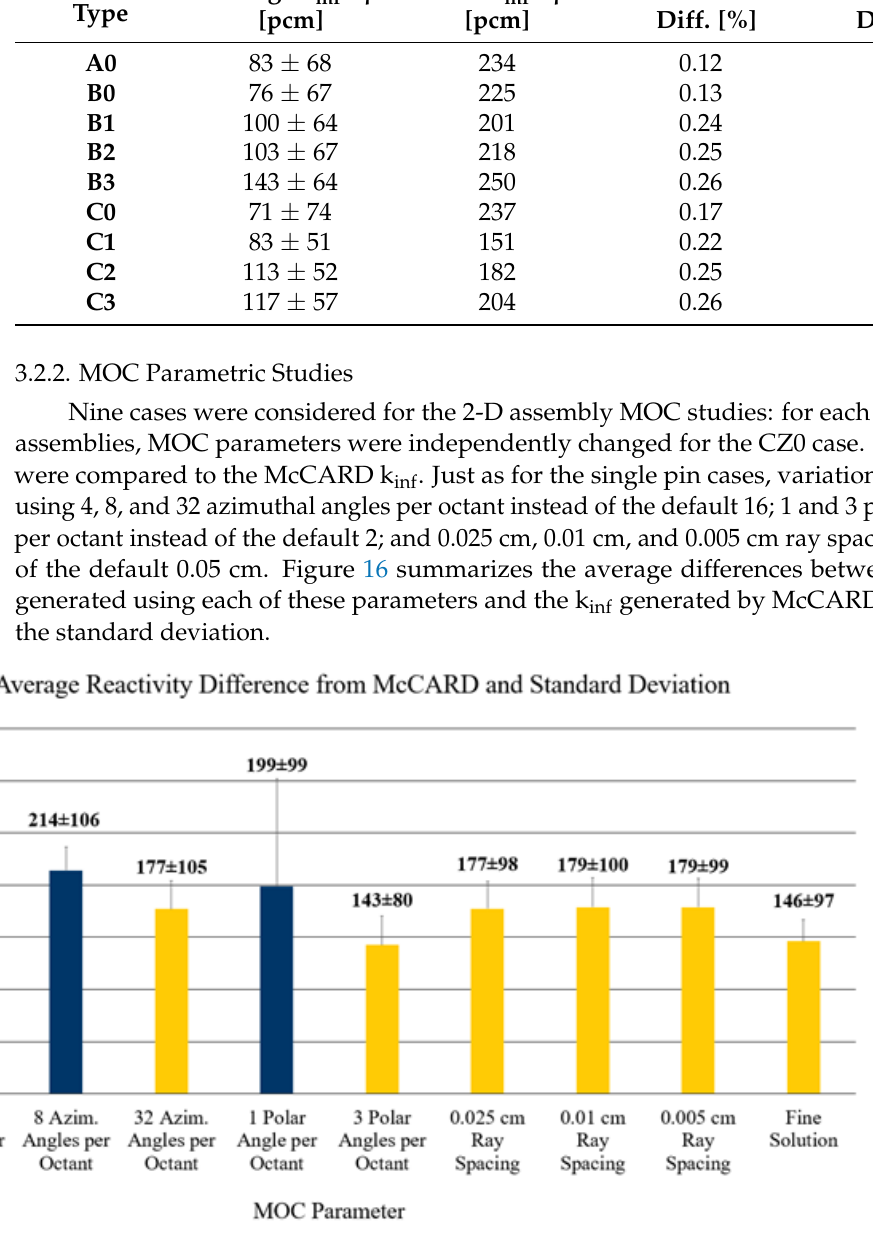
Figure 16. Average difference from MPACT default k inf for 2-D assembly MOC